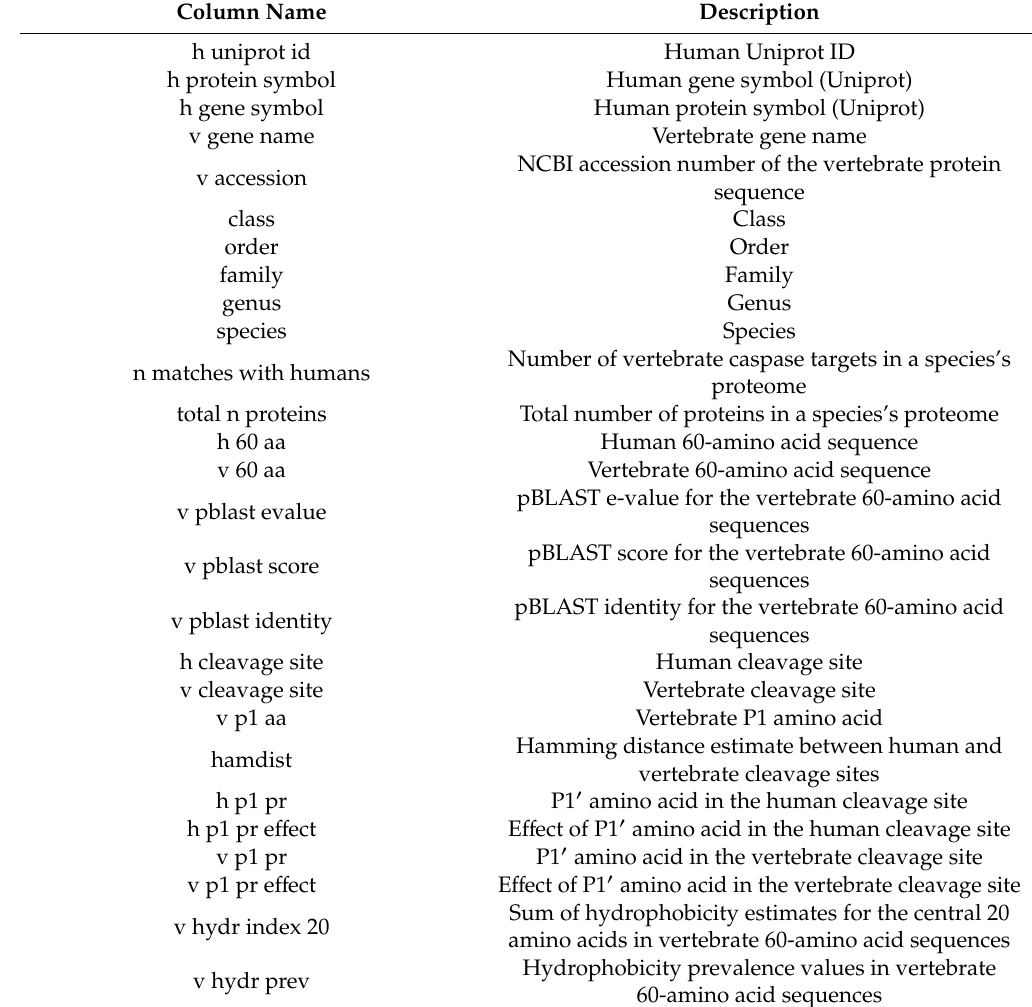
Table A2. Column names and descriptions for Table S2.